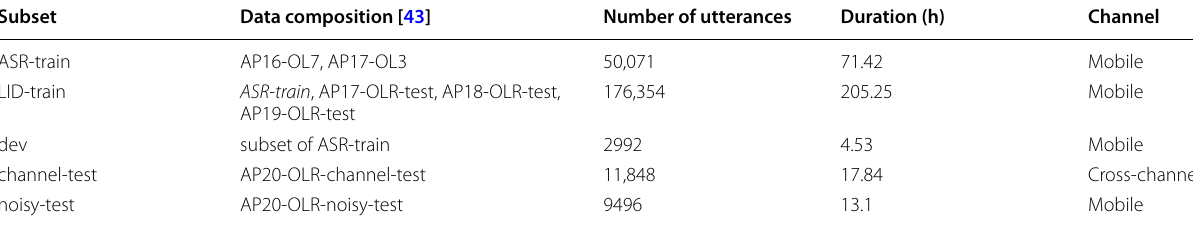
Table 2 Details of the OLR